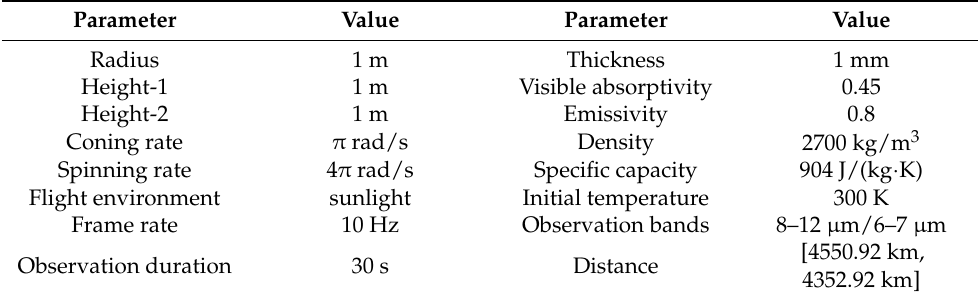
Table 4. Simulation